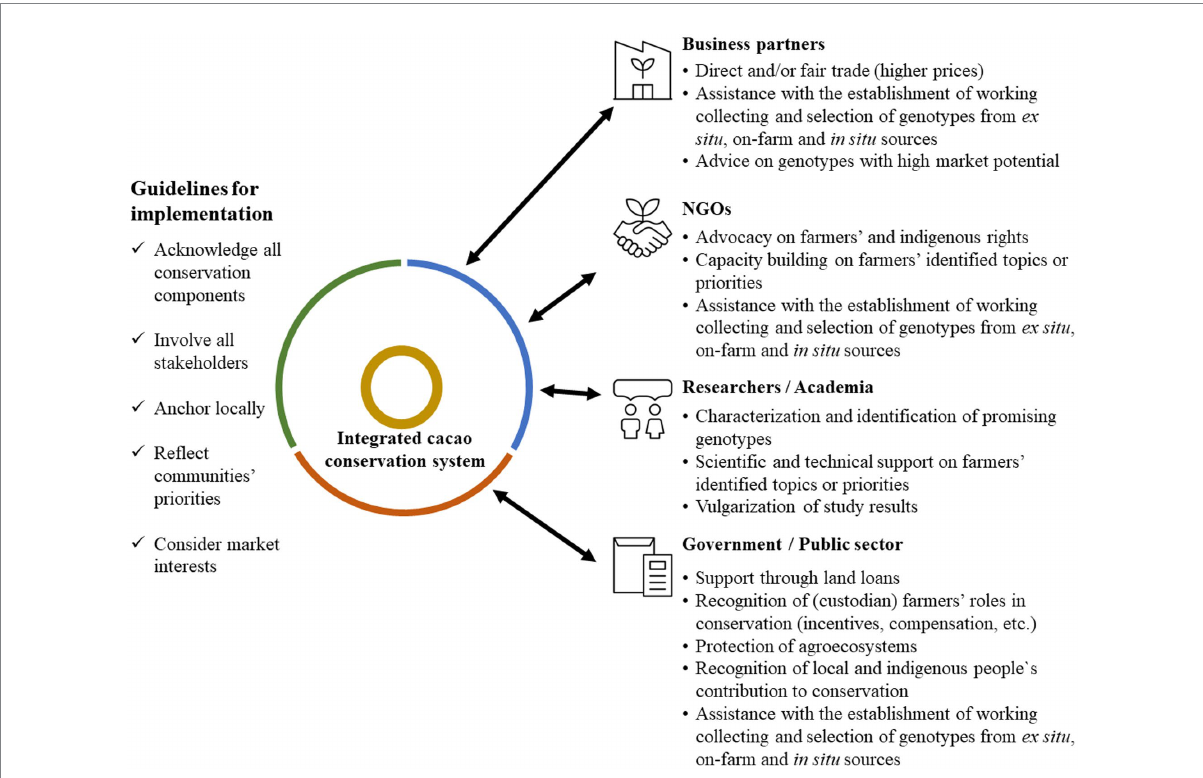
FIGURE 3 Potential roles of conservation actors outside of local